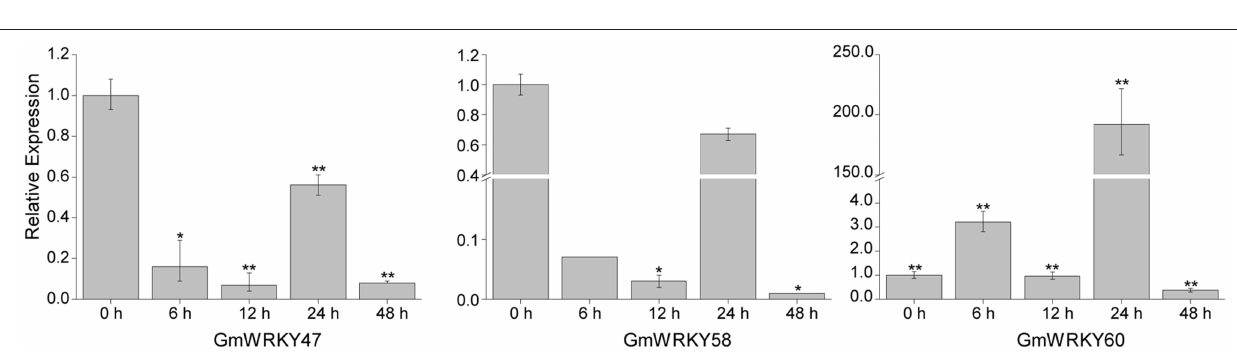
developmental stages. GmWRKY54 , 62 , 125, and 180 genes were expressed in 14 DAF seeds, but not in other seed developmental stages ( Figure 6